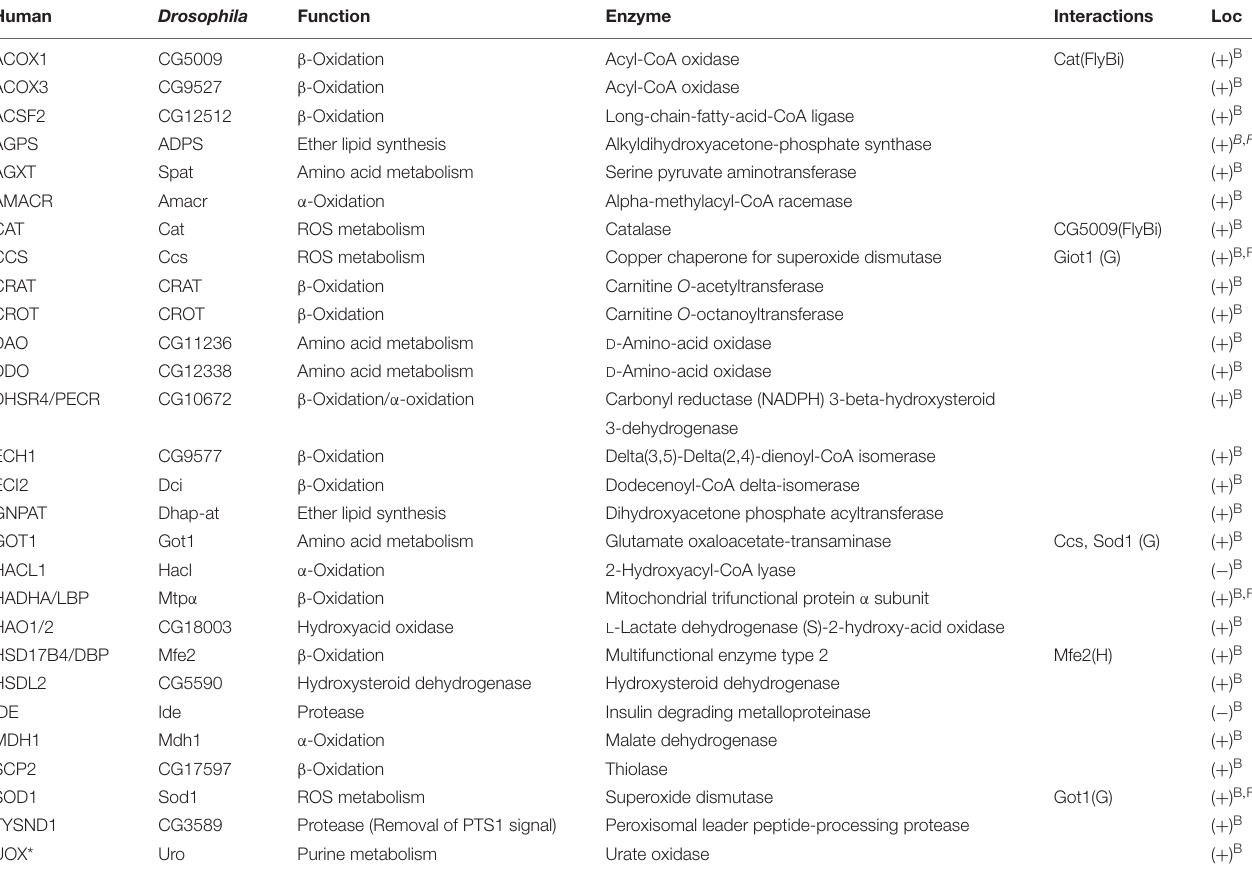
“Interactions”: Protein interactions indicate interaction between these protein partners in G) whole proteome mass-spectrometric identification G-(Guruharsha et al., 2011) or experimentally by H-(Haataja et al., 2011). “Loc”: ( + ) experimentally validated localization to peroxisomes, ( − ) did not localize to peroxisomes in B-(Baron et al., 2016) F-(Faust et al., 2012). *UOX is a pseudogene in